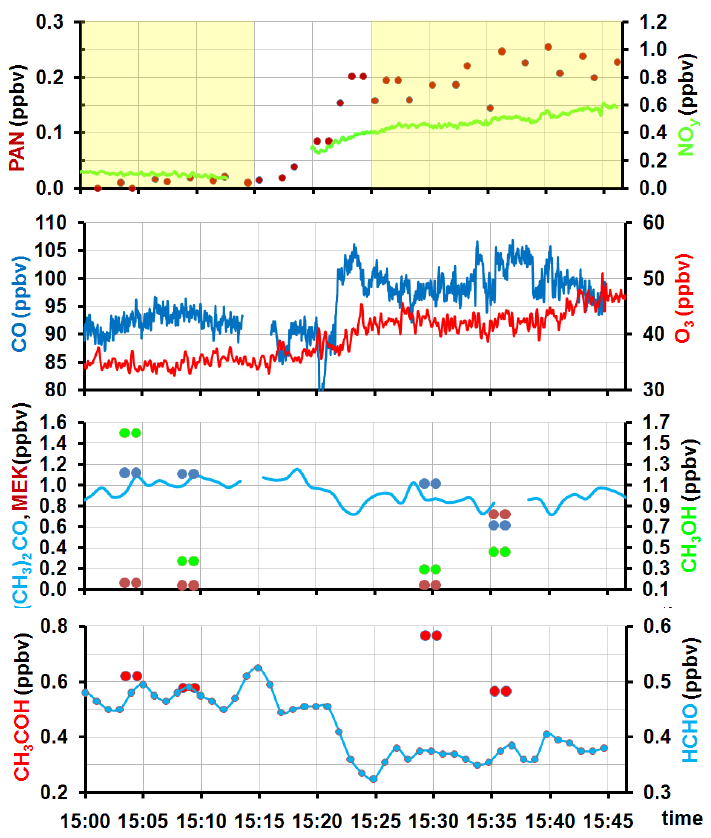
Figure 8: Variation of related trace gases during the AMMA radical intercomparison exercise: CO, O 3 , NO y , and HCHO as measured on board the D-Falcon, (CH 3 ) 2 CO, CH 3 COH, MEK, PAN and CH 3 OH as measured on board the BAe-146. The (CH 3 ) 2 CO measured by PTR-MS (blue line) agree reasonably with the WAS samples (blue dots). The periods of the intercomparison are highlighted in the top figure in yelow.